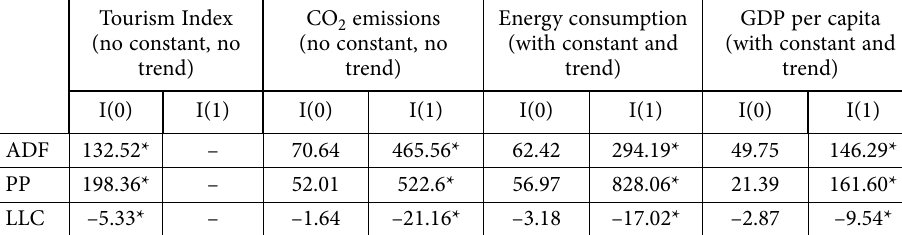
Table 7. Panel data unit root tests (source: own computations using EViews 10) Tourism Index CO 2 emissions Energy consumption GDP per capita (no constant, no (no constant, no (with constant and (with constant and trend) trend) trend)